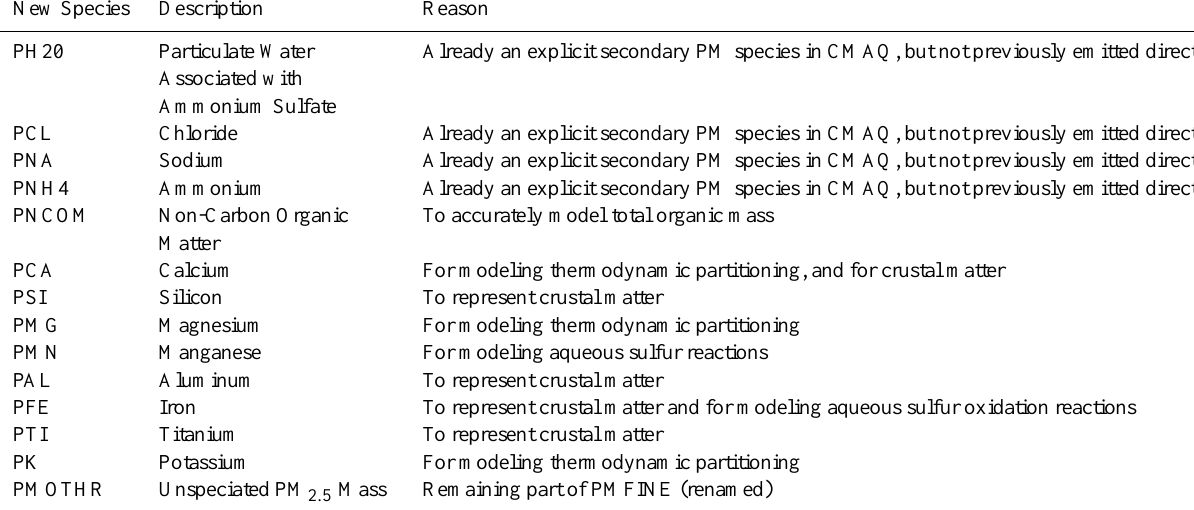
Table 2. The revised speciation of PMFINE and the reasons for making them explicit. New